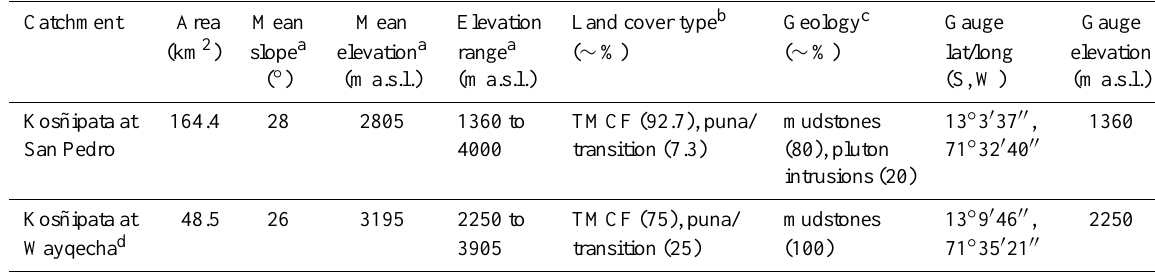
Table 1. Descriptions of the Kosñipata catchment.